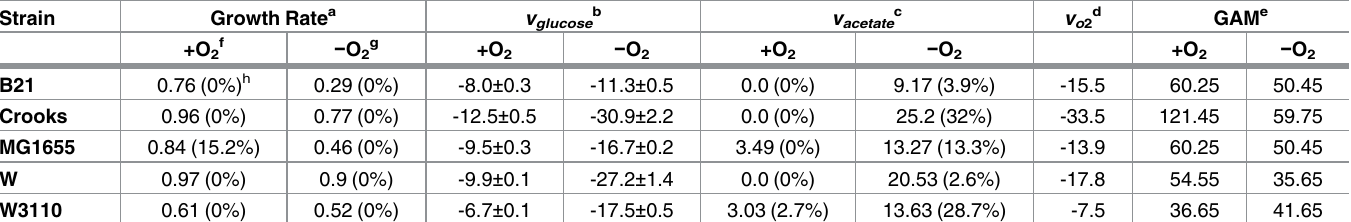
Table 1. Growth characteristics of models of the E. coli strains examined in the current study. Results are shown for models [27–29]where maximal O 2 and growth associatedATP maintenance have been fitted to minimizedeviationfrom experimental acetate productionand growth rates.